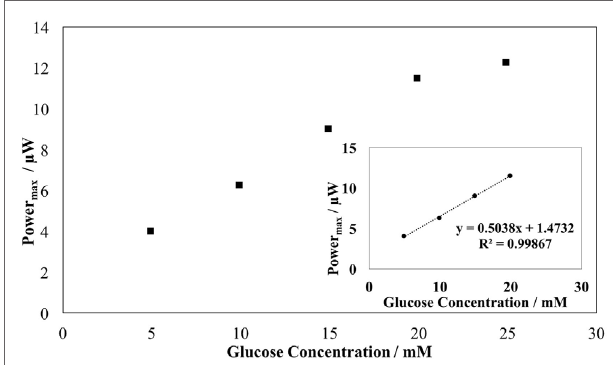
FigUre 4 | cell voltage vs. current density curve of the biofuel cell operating in human serum and different glucose additions, at room temperature .